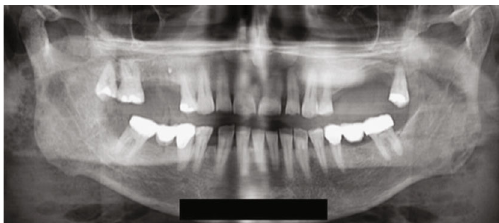
Figure 2: Initial orthopantomography (OPG) X-ray 13/02/2021: partial edentulism; outcomes of conservative and orthodontic therapy, prosthetic rehabilitation.